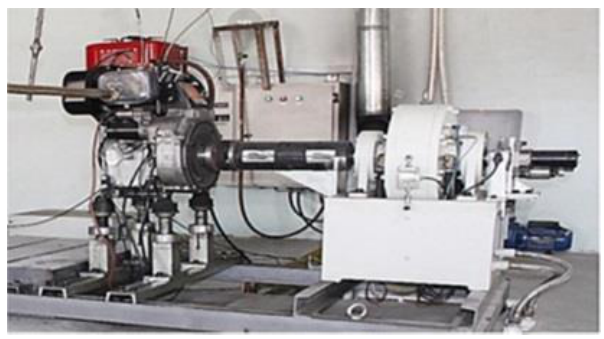
Fig. 5. Engine and dynamometer